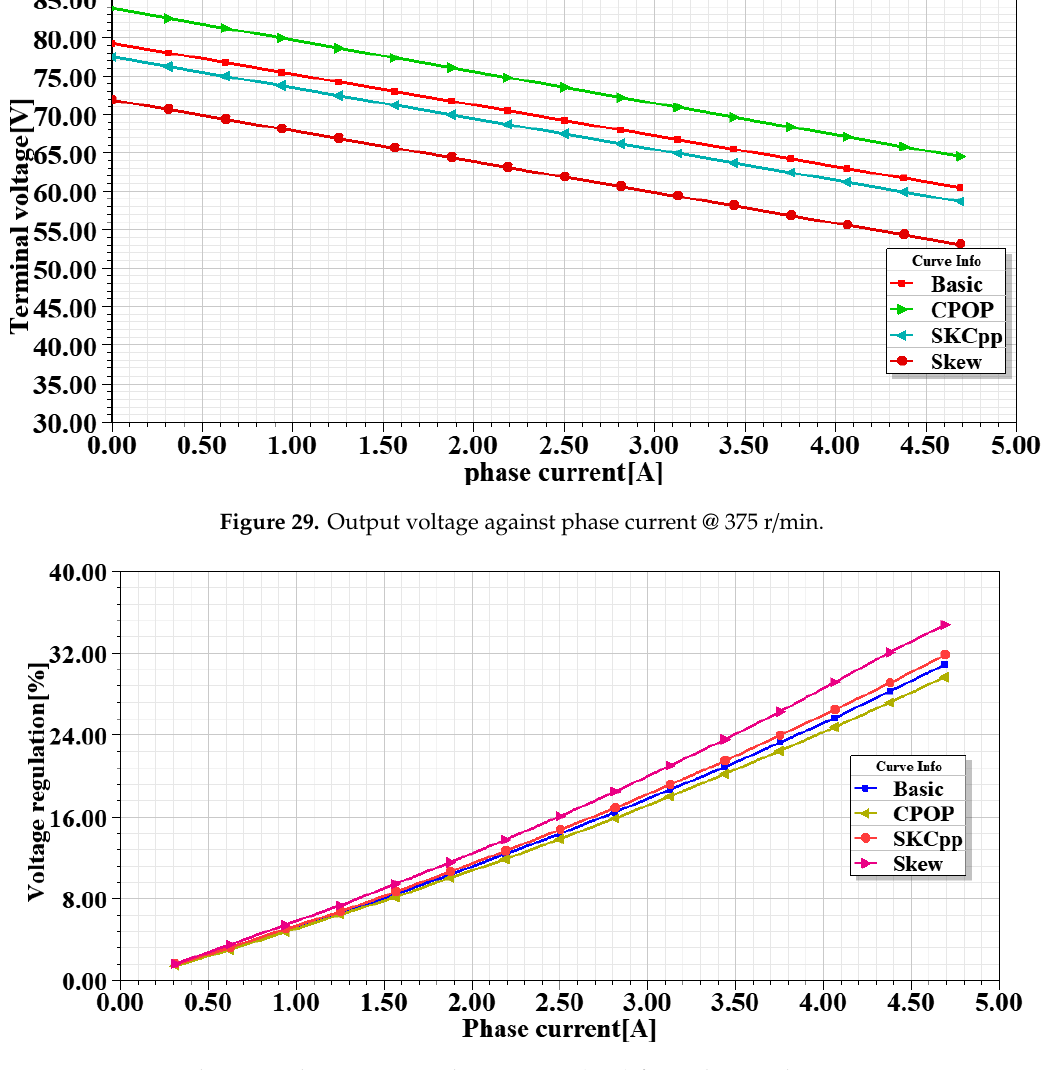
Figure 31. Output-power against phase current (rms) for each rotor designs @ 375 r/min. Figure 32. Efficiency against phase current (rms) for each rotor designs @ 375 r/min.